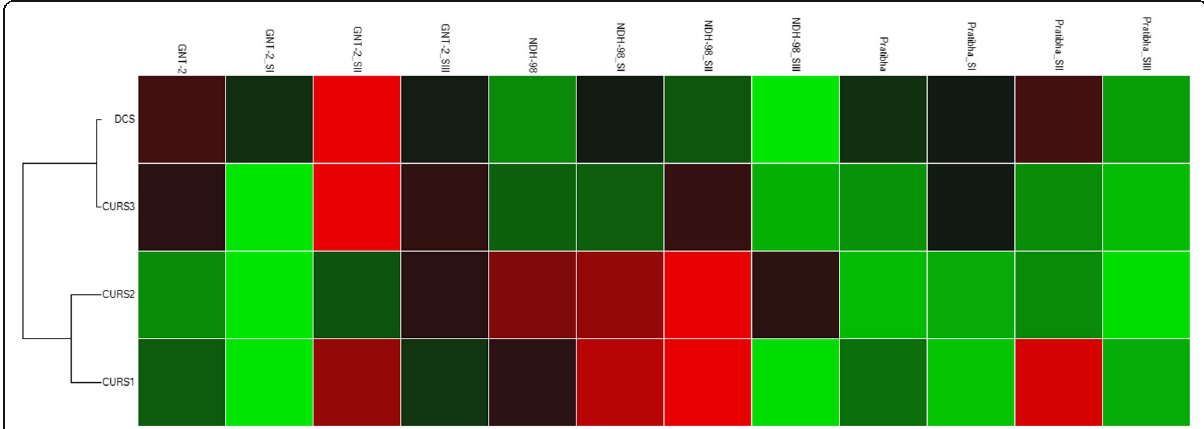
Fig. 3 Cluster gram showing the association between the gene expressions in turmeric at three growth stages. NDH-98, GNT-2, and Pratibha are three turmeric cultivars. SI, 4 months after planting; SII, 5 months after planting; SIII, 6 months after planting. Upregulation (higher expression) is shown by a red square, downregulation (lower expression) by a green square, and no regulation by a black square. The lighter the shade of color, the greater the relative expression difference. Gene expression patterns of DCS and CURS3 were more closely associated and distant from CURS1 and CURS2 gene expression patterns among the genotypes at all stages of growth. The upregulation of most of the genes was found at SII as compared with other states under study. GNT-2, NDH-98, and Pratibha expressions are the average expressions of all three stages